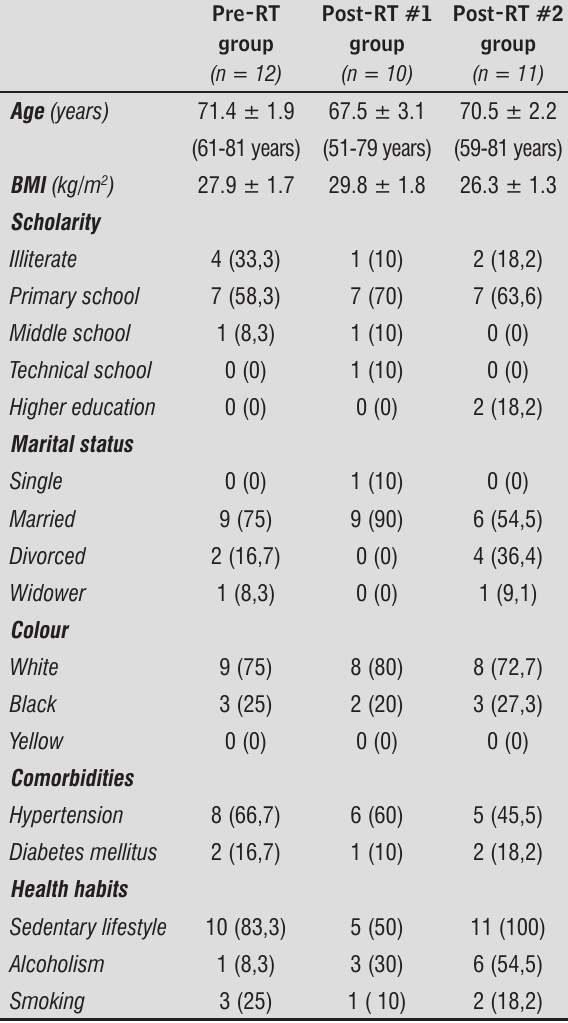
Table 1 - Sociodemographic and personal data [ mean ± SD; n ( % ); (range) ]